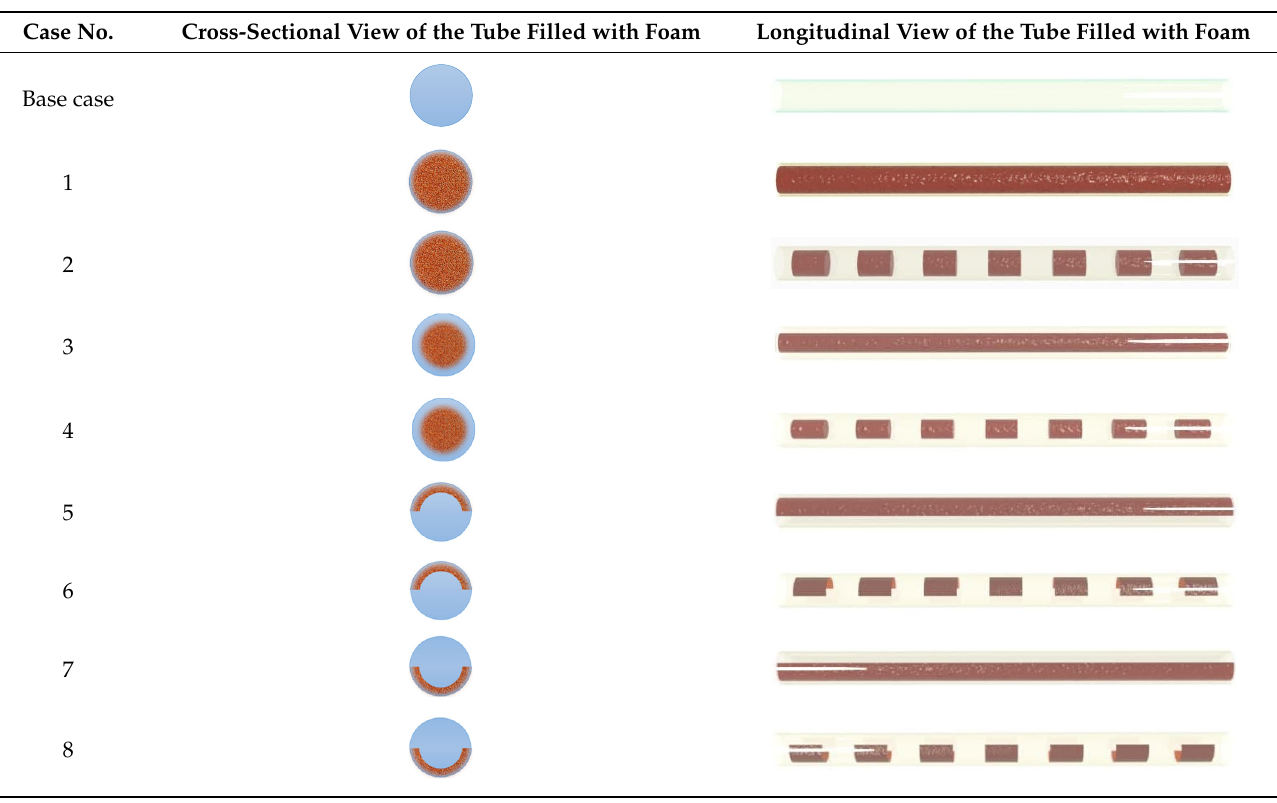
Table 3. Different considered layouts of the metal foam inside the DAPTC.